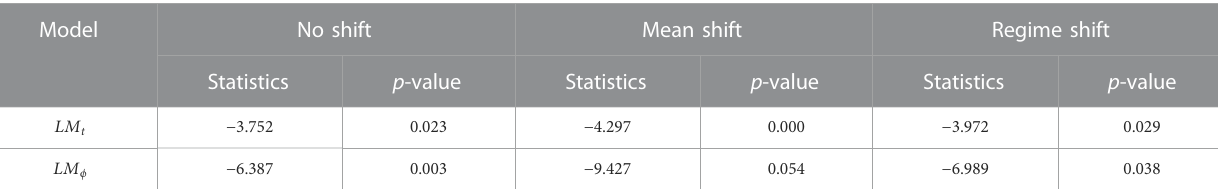
TABLE 6 Results of Westerlund and Edgerton cointegration